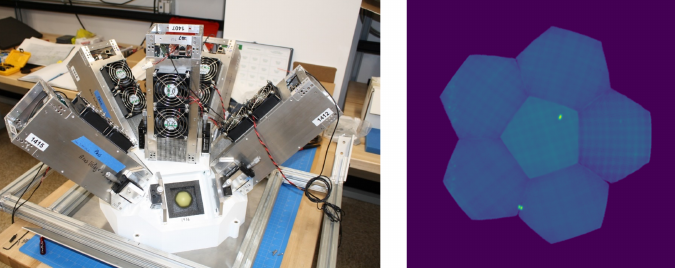
Figure 2. Assembled prototype and a pair of Bragg peaks collected with a single crystal and monochro- matic